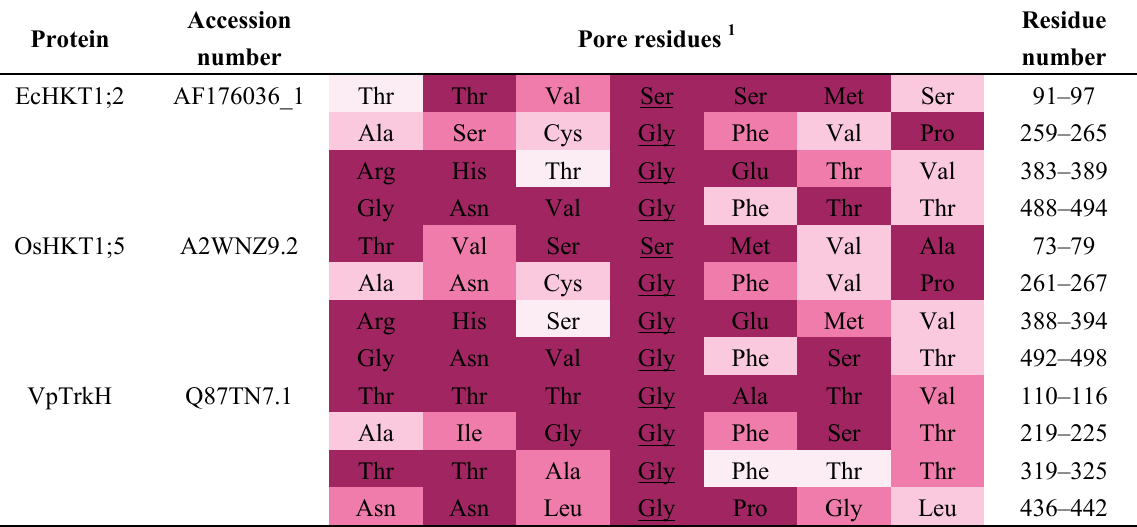
Table 2. The amino acid residues, given in three-letter codes, lining pores of the EcHKT1;2, OsHKT1;5 and VpTrkH transporters. The predicted selectivity filter residues are